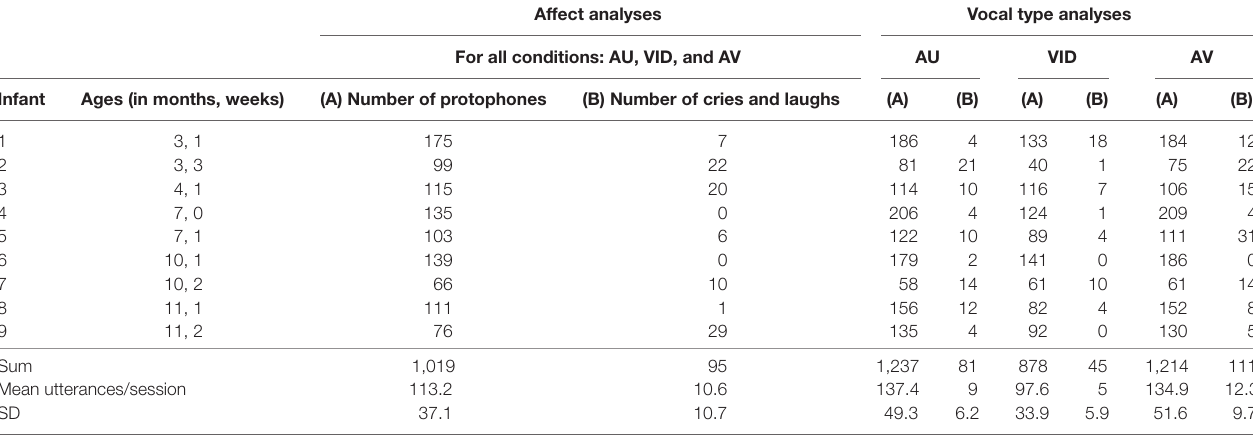
TaBle 1 | Nine recordings from nine infants spanning the first year were drawn from a larger study (Oller et al.,